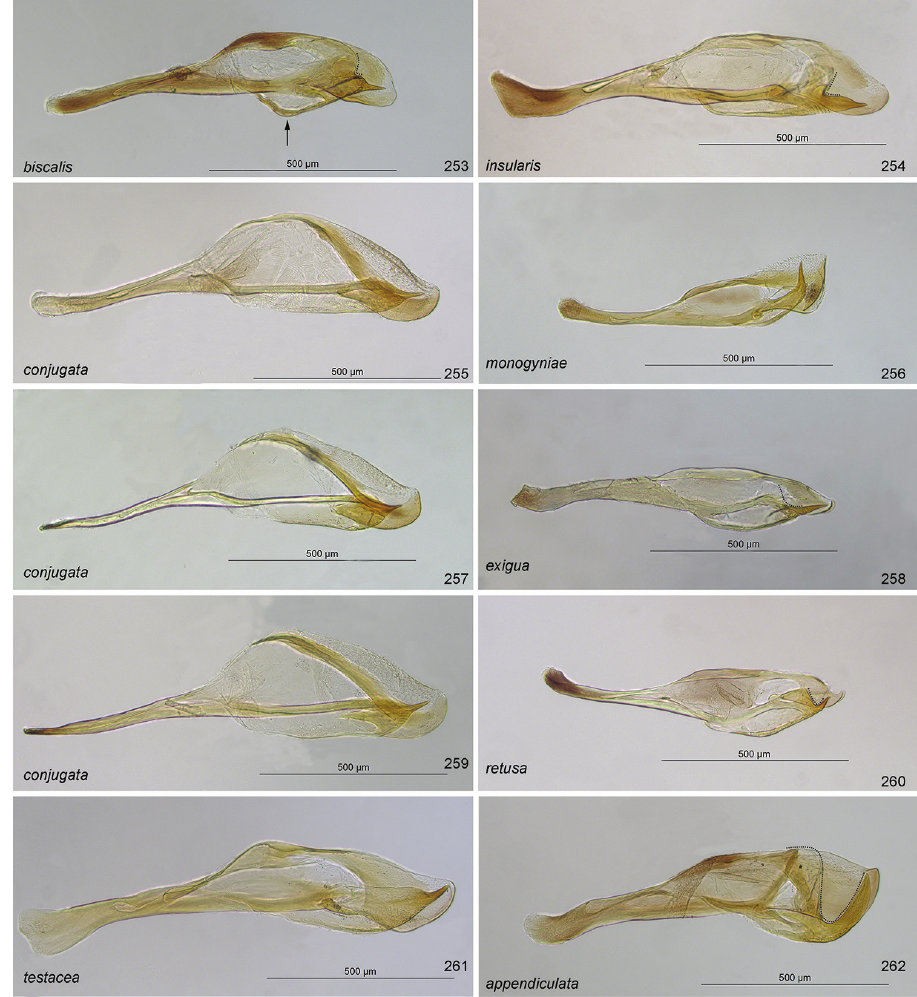
Figures 253–262. Penis valves of Pristiphora . 253 biscalis DEI-GISHym31533 (arrow indicates protrud- ing ventral margin of paravalva) 254 insularis DEI-GISHym20941 255 conjugata DEI-GISHym31542, reared from Populus sp. 256 monogyniae DEI-GISHym31590 257 conjugata DEI-GISHym80024, reared from Salix fragilis 258 exigua holotype 259 conjugata DEI-GISHym31544, reared from Salix pentandra 260 retusa DEI-GISHym20791 261 testacea DEI-GISHym31631 262 appendiculata DEI-